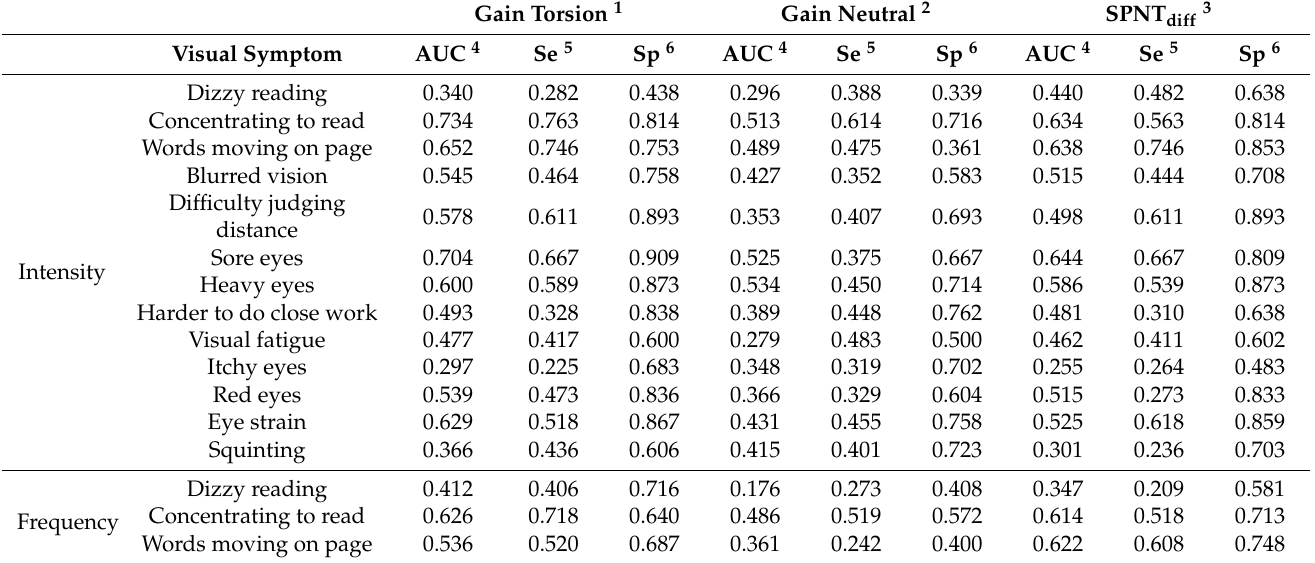
Table 2. Relation between visual symptoms, gain, and SPNT diff